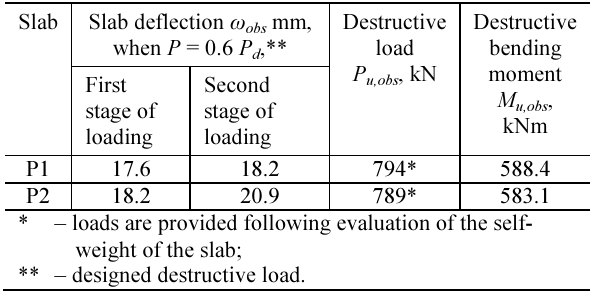
Table 3. Results of slab testing Slab Slab deflection ω obs mm, when P = 0.6 P d ,** First Second stage of stage of loading loading